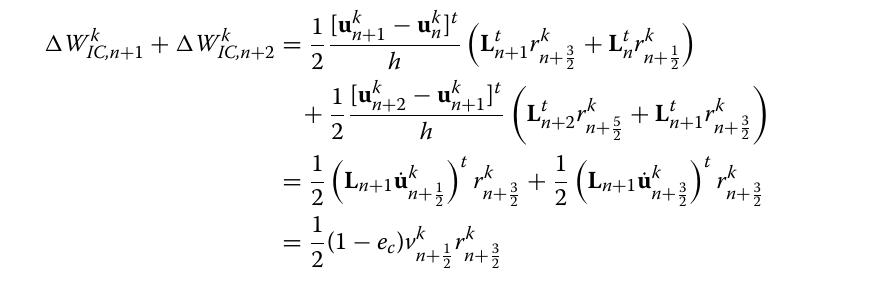
Fig. 3 Bouncing ball—position for Carpenter’s schemes— e c =